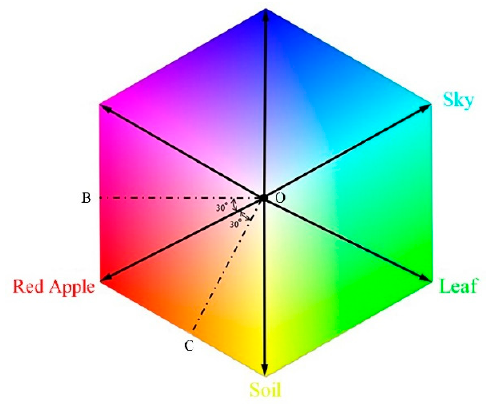
Figure 9. The choice of different COI (red apple, soil, sky, and leaf) under the angle of view perpendicular to the gray center in the gray-center color space.